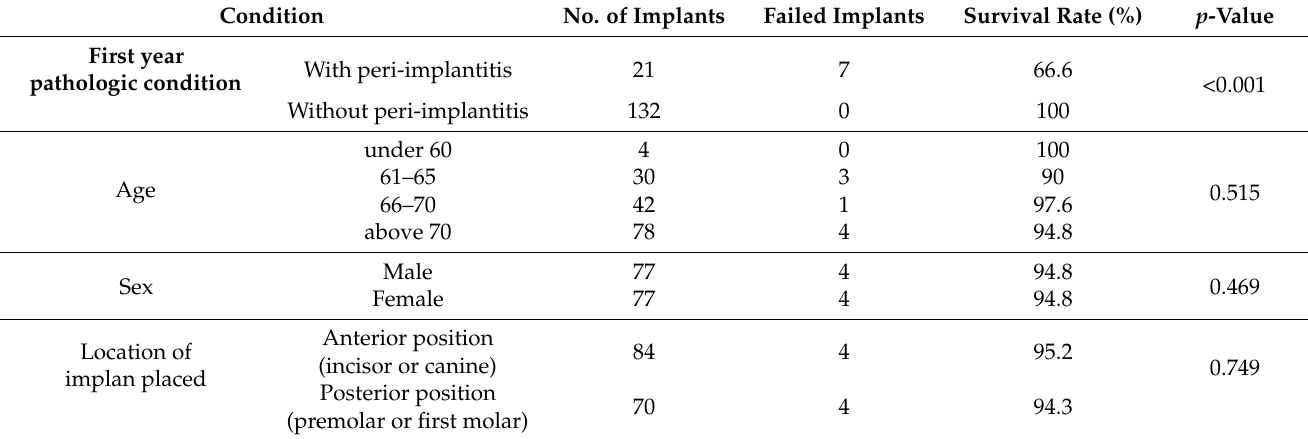
Table 4. Survival rate of implants and p -value according to variables.